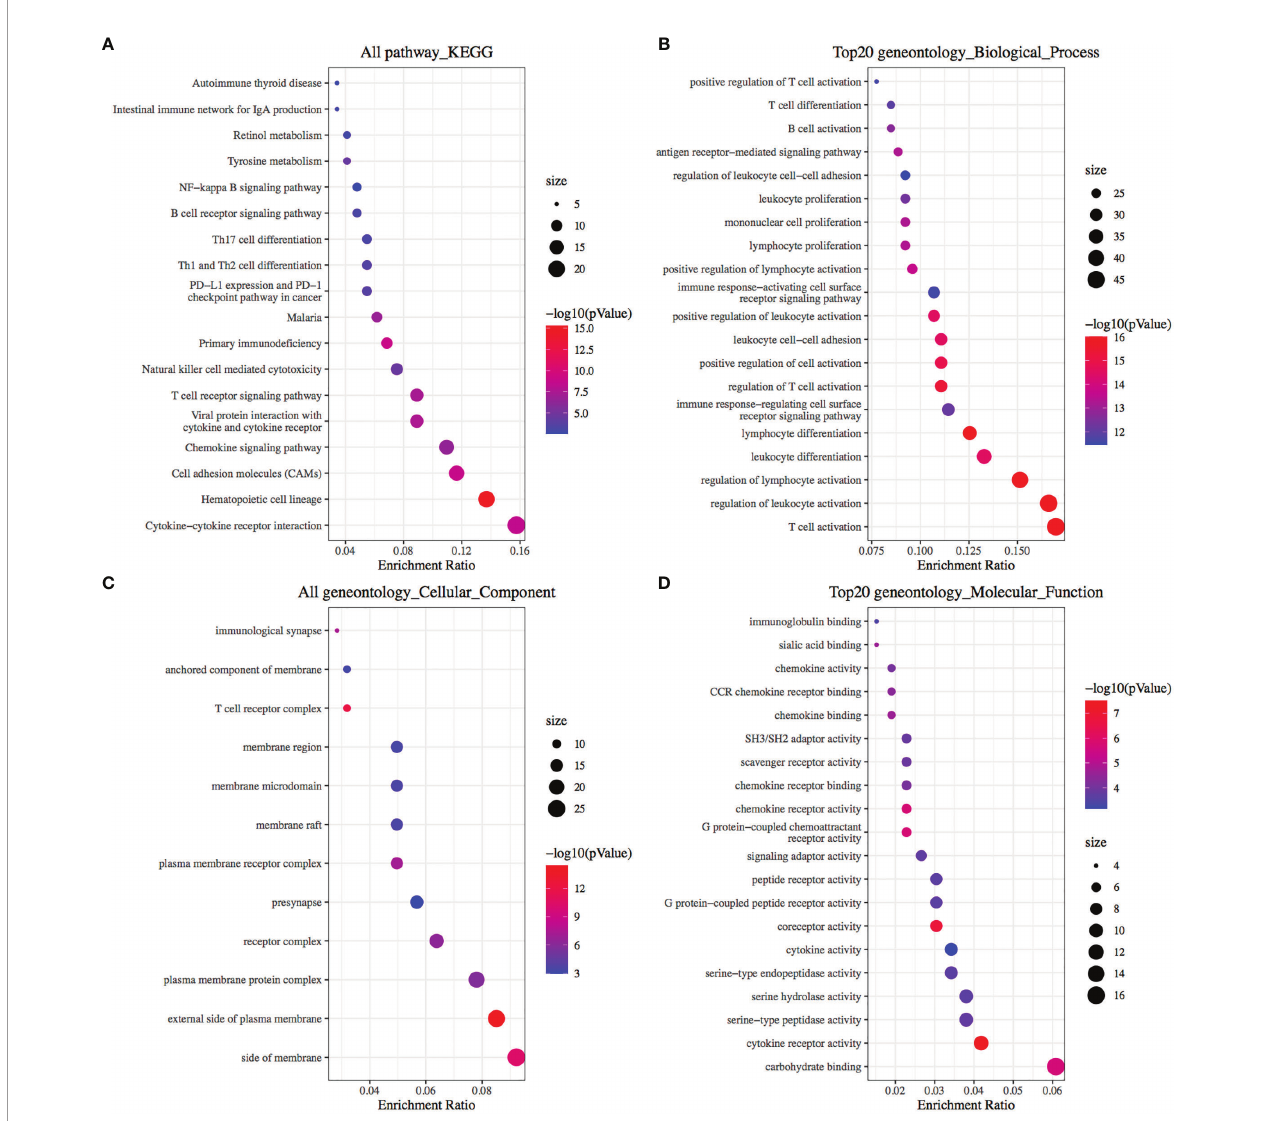
FIGURE 2 | Enrichment Analysis of DEGs identi fi ed from comparing CD8+ T cells high in fi ltration group and low in fi ltration group. (A) Bubble plot of signi fi cant KEGG pathways. X-axis indicates the gene ratio, whereas the Y-axis shows the most enriched KEGG pathways. And the size of bubble presents genes number, and the color of bubble presents the P value. (B – D) GO analyses of the DEGs according to their biological process, cellular component and molecular function. X-axis indicates the gene number, whereas the Y-axis shows the most enriched GO